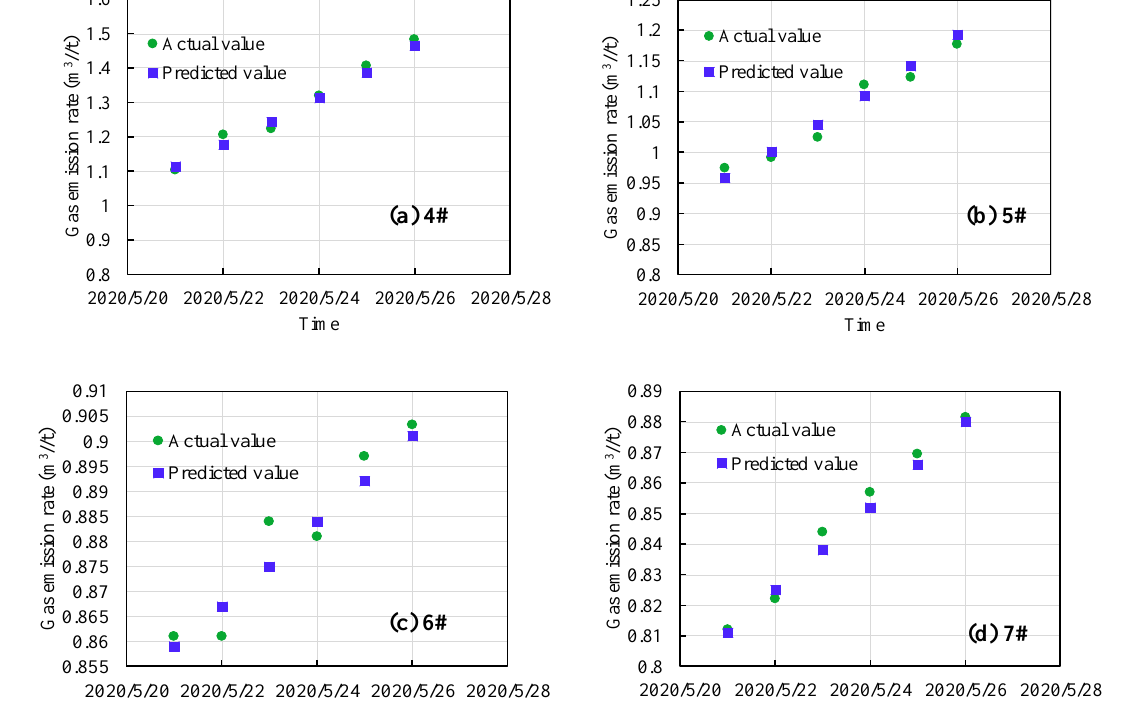
Figure 7. Comparison of gas prediction and actual data in the intake and return air roadways of the working face. ( a ) 4# location; ( b ) 5# location; ( c ) 6# location; ( d ) 7# location.